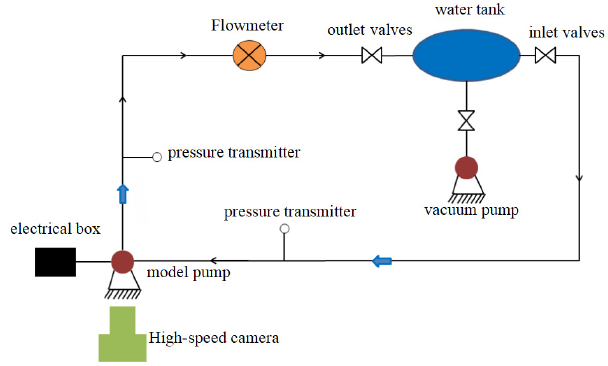
Figure 5. Schematic diagram of the testing loop.